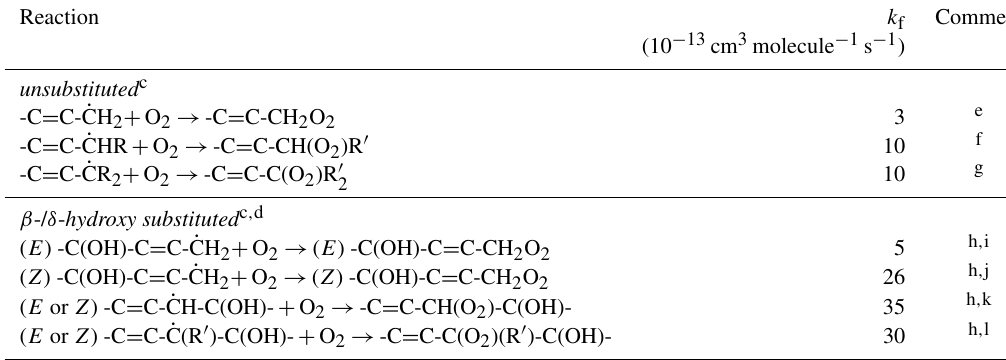
Table 17. Partial rate coefficients for the addition of O 2 to radicals possessing an allyl resonance a , b . Reaction k f Comment (10 − 13 cm 3 molecule − 1 s − 1